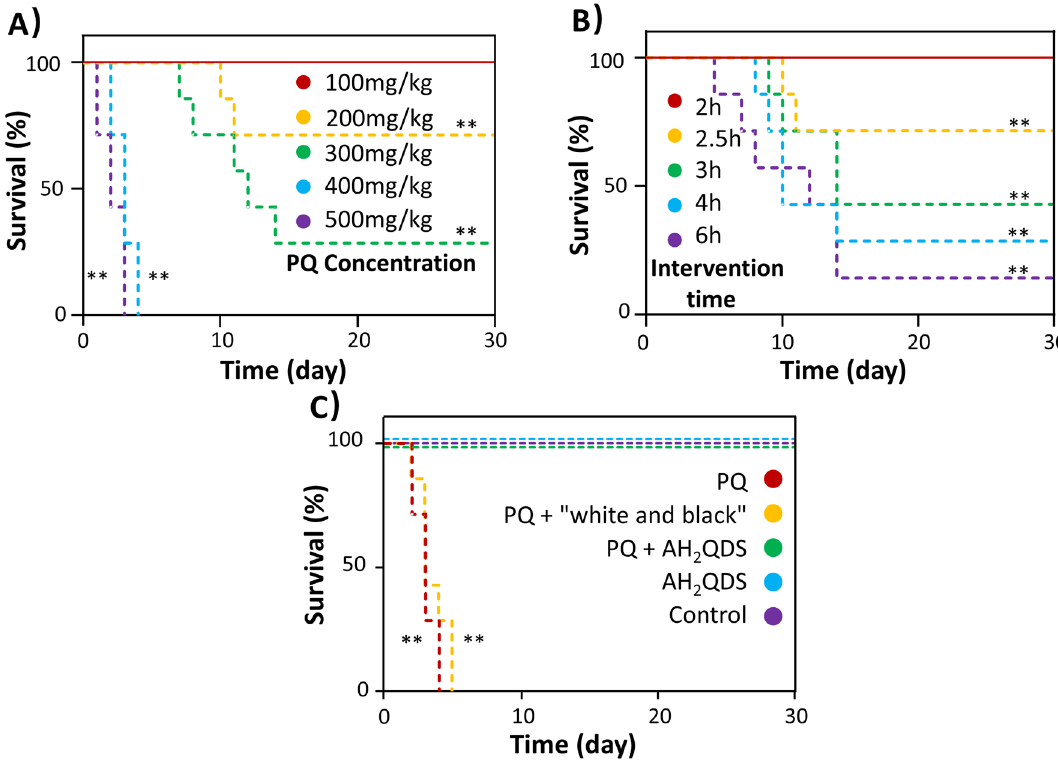
Figure 4. AH 2 QDS can improve the survival rate of rats with PQ poisoning. ( A ) The survival of rats with different concentrations of PQ. ( B ) Prolong the time of AH 2 QDS intervention in rats with PQ poisoning and observe the changes in survival rate. ( C ) The survival curve of rats in different treatment groups. The untreated control group did not make any interventions. In the AH 2 QDS group, only 400 mg/kg AH 2 QDS antidote was given by gavage. PQ was given by gavage only at a concentration of 400 mg/kg in the PQ group. In the PQ + "white and black" group, 400 mg/kg of PQ was given by gavage first, and 500 mg/kg was given by gavage 2 h later, with a "white and black" scheme. In the PQ + AH 2 QDS group, 400 mg/kg of PQ was given to the stomach first, and 400 mg/kg of AH 2 QDS antidote was given 2 h later. Kaplan–Meier survival analysis was